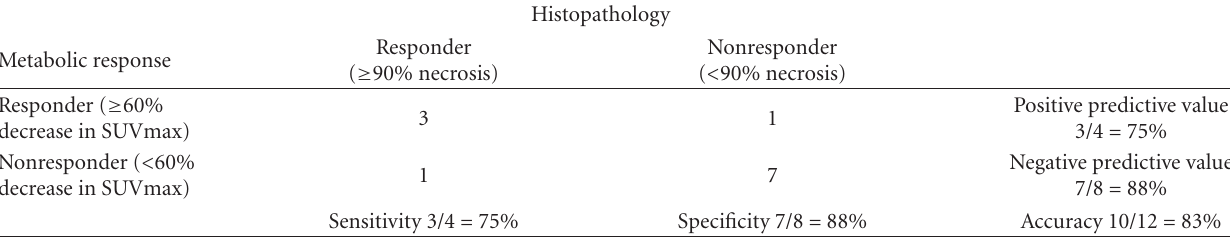
Figure 4: FDG-PET/CT at baseline, early followup, and after completion of neoadjuvant treatments in a histopathological responder (a) and a nonresponder (b). Table 2: Correlation between histopathologic and metabolic response ( ≥ 60% decreases in SUVmax).